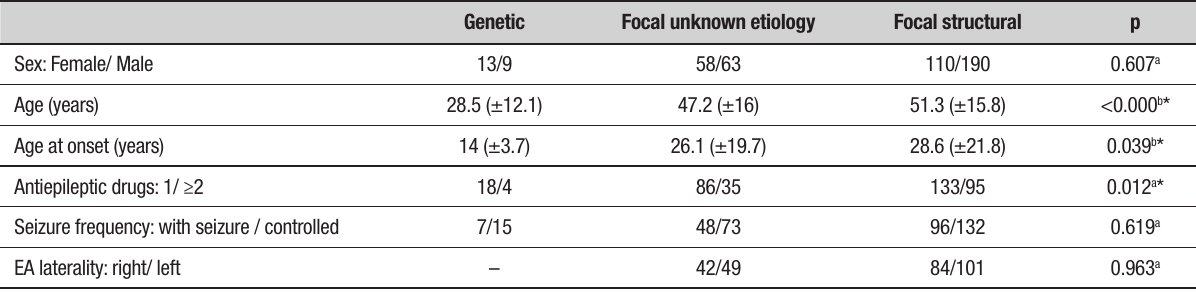
Table 1. Sociodemographic and clinical aspects of 371 people with epilepsy.